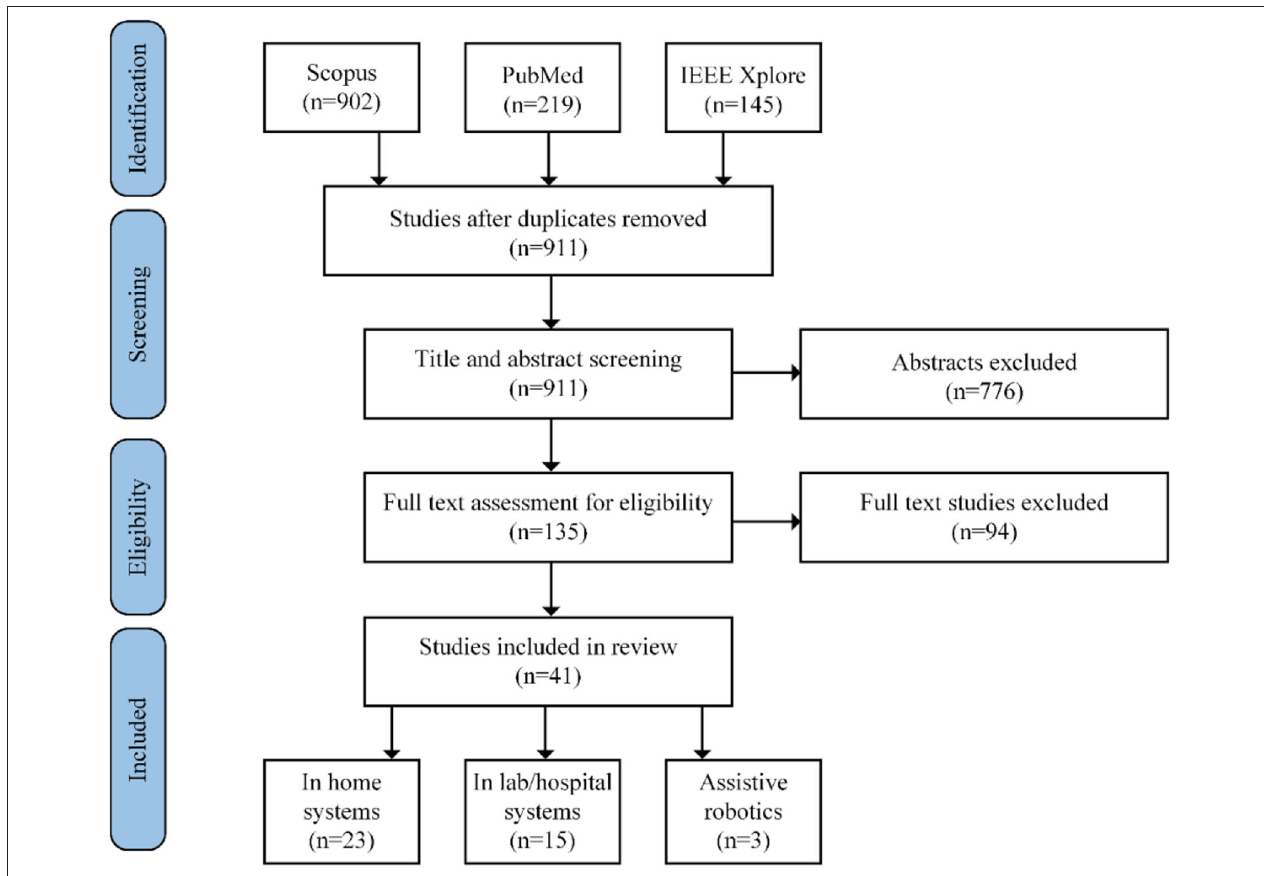
FIGURE 1 | Literature search and screening methodology along with paper selection